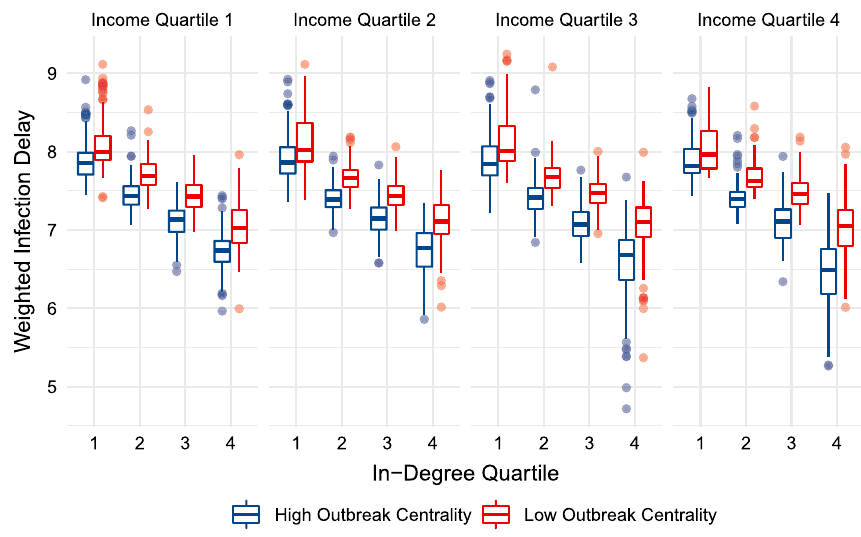
Fig. 10 Un-weighted infection delay values across in-degree centrality quartiles, while controlling for income. Each region’s infection delay values are calculated and displayed for outbreak scenarios in the upper and lower 50% of in-degree centrality